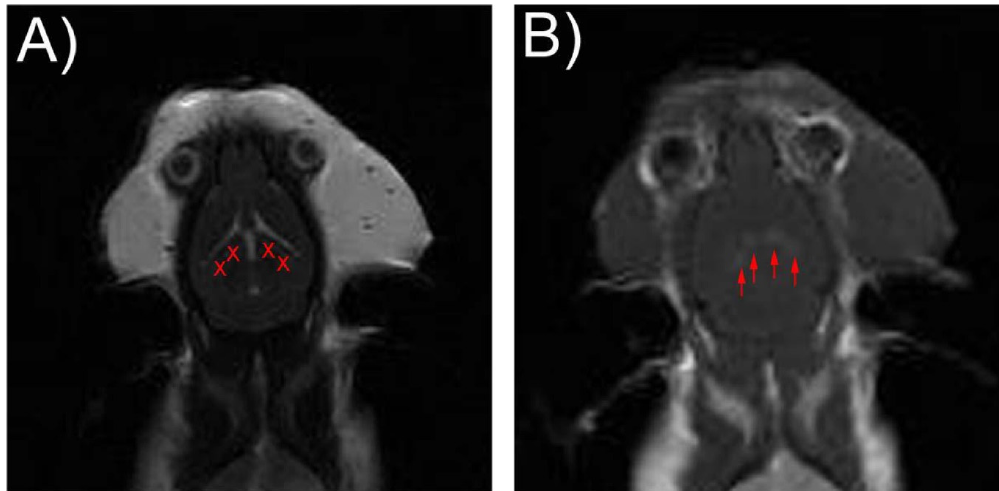
Figure 4. BBB (blood-brain barrier) disruption in MRI (magnetic resonance imaging). ( A ) Four spots in the dorsal hippocampus were chosen marked with × in T2-weighted images. ( B ) Following sonication, in T1-weighted images, four hyperintense spots (marked with red arrow) illustrated BBB disruption with injection of gadolinium contrast agents (0.2 mL/kg; Omniscan, GE Healthcare, Milwaukee,